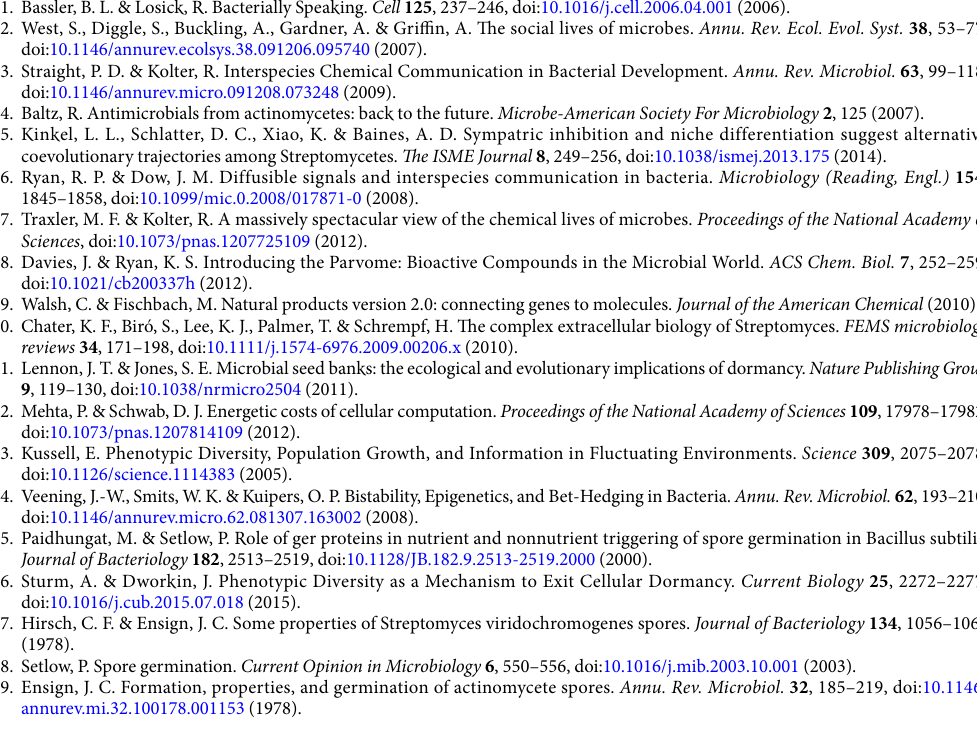
12 Scientific RepoRts | 7: 699 | DOI:10.1038/s41598-017-00792-7